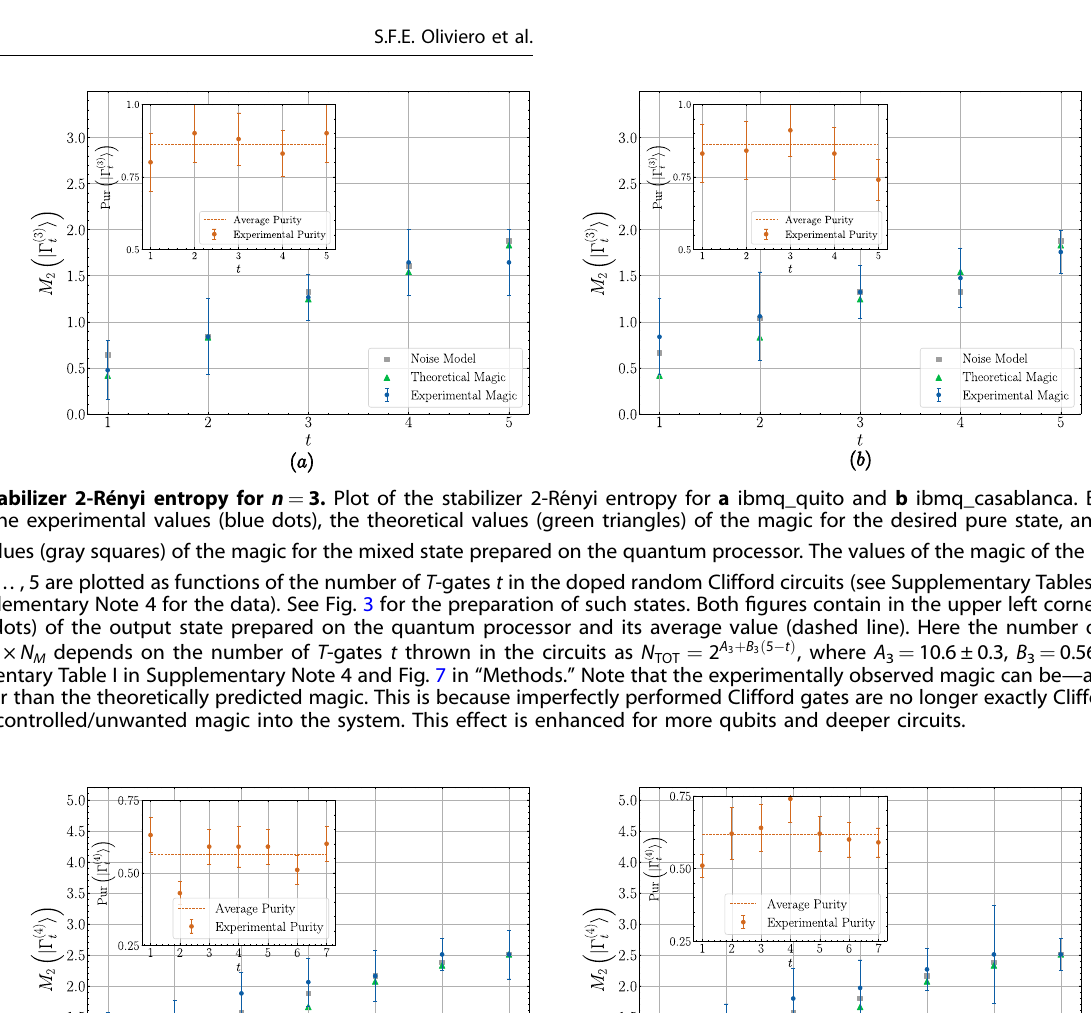
(cid:5) E (cid:5) (cid:5) -states